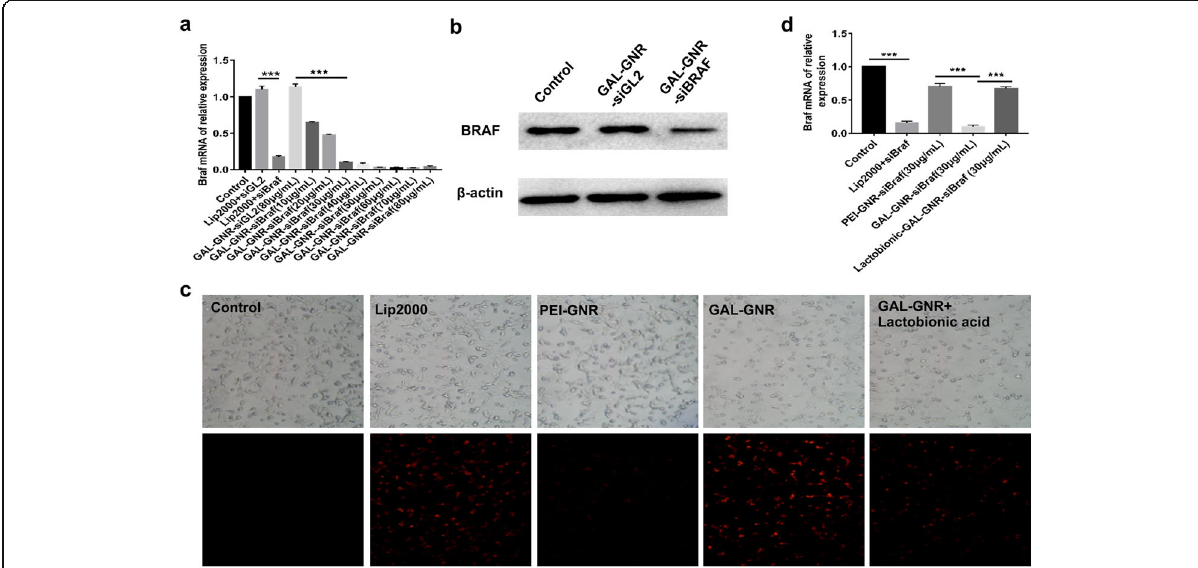
Fig. 4 Hepatoma cell-targeted delivery of siRNA and gene silencing of BRAF in vitro. a The mRNA of BRAF expression after GAL-GNR-siBRAF transfection. Hepa1-6 cells were transfected with various concentrations of GA-GNR carrying the same amount BRAF siRNA (1 μ g) for 24 h. The expression of BRAF mRNA was determined by qPCR. The error bar represents the standard deviation of three experiments (*** p < 0.001). b The protein expression of BRAF in Hepa1-6 after GAL-GNR-siBRAF transfection. Hepa1-6 cells were transfected with GAL-GNR-siBRAF, GAL-GNR-siGL2, or PBS for 48 h, the levels of BRAF and β -actin were determined by Western blot. c and d Liver cancer-targeted delivery ability of GAL-GNR- siBRAF. One microgram of cy3-labled siBRAF was incubated with lip2000, PEI-GNR (30 μ g/mL), GAL-GNR (30 μ g/mL) for 20 min at room temperature and then added to the media of Hepa1-6 cells. For competitive inhibition assay, Hepa1-6 cells were pre-treated with Lactobionic acid overnight. The intracellular fluorescence intensity was observed under the fluorescence microscope (scale bar = 200 μ m), and the mRNA expressions of BRAF were quantified by q-PCR. The error bar represents the standard deviation of three experiments (* p <